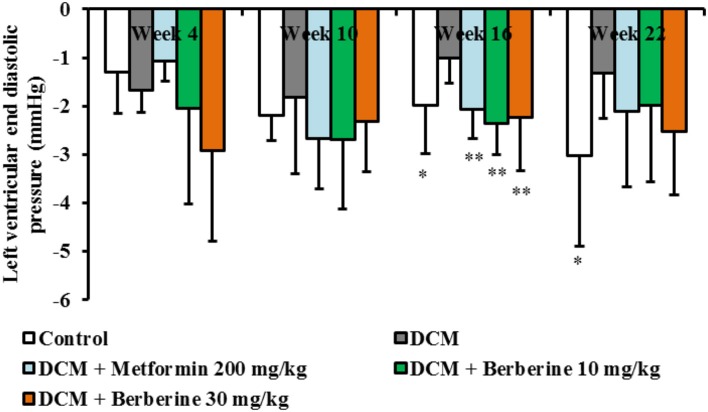
Berberine improved cardiac diastolic function in DCM rats. Diabetic cardiomyopathy (DCM) model rats were established by feeding with high-sucrose and high-fat diet (HSHFD) consisting of regular diet (66.5%), lard (10%), sucrose (20%), cholesterol (2.5%), and bile salt (1%) and intraperitoneally (i.p.) injected with 30 mg/kg of streptozotocin (STZ) at the fifth week. Seventy-two hours after STZ injection, berberine at the dosage of 10, 30 mg/kg, and metformin at 200 mg/kg were orally given to DCM rats, respectively, for consecutive 4, 10, 16, and 22 weeks. The dynamic changes of cardiac function were measured by invasive left ventricular catheterization in anesthetized rats. DCM, diabetic cardiomyopathy. Data were shown as mean ± SD, with n = 7~12. Statistical significance was determined by one-way analysis of variance (ANOVA) followed by least significant difference (LSD) post-hoc test. *P < 0.05, **P < 0.01 vs. DCM group.